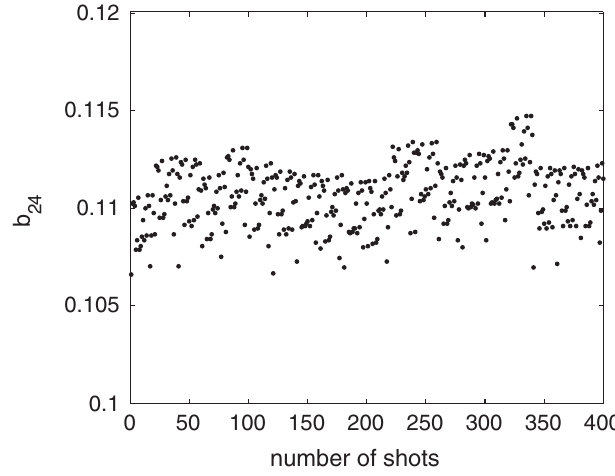
FIG. 9. Bunching factors for the 24th harmonic at various shots for a fluctuating amplitude of the laser power.